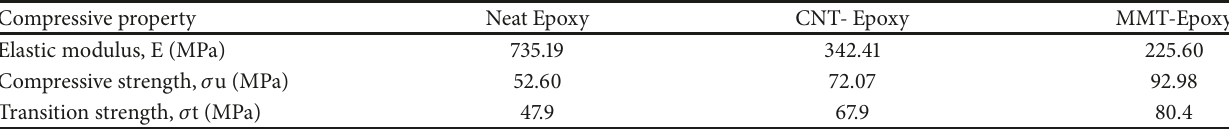
Table 4: The compressive properties of neat, MMT, and CNT epoxy